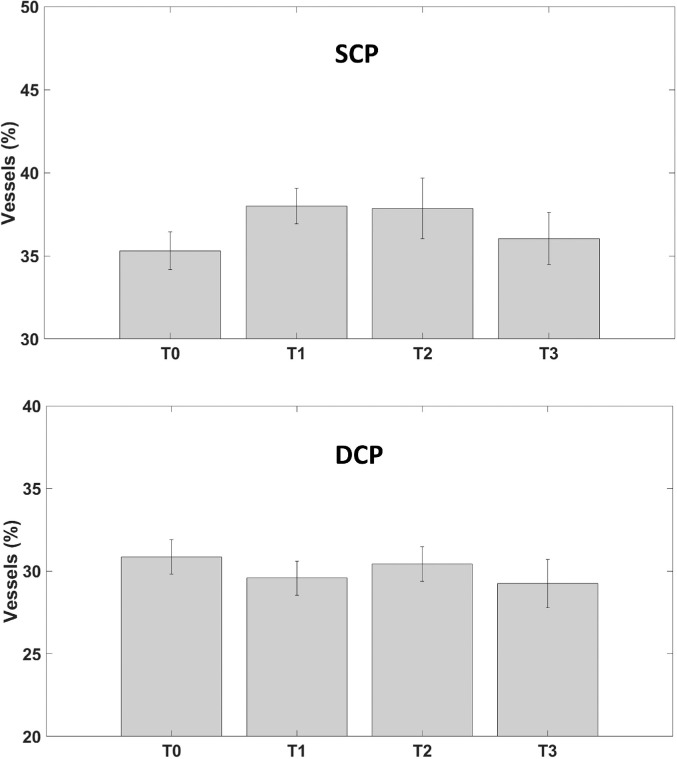
Vessel density modification during follow-up of SCP (top, in percentage) and of DCP (bottom, in percentage).